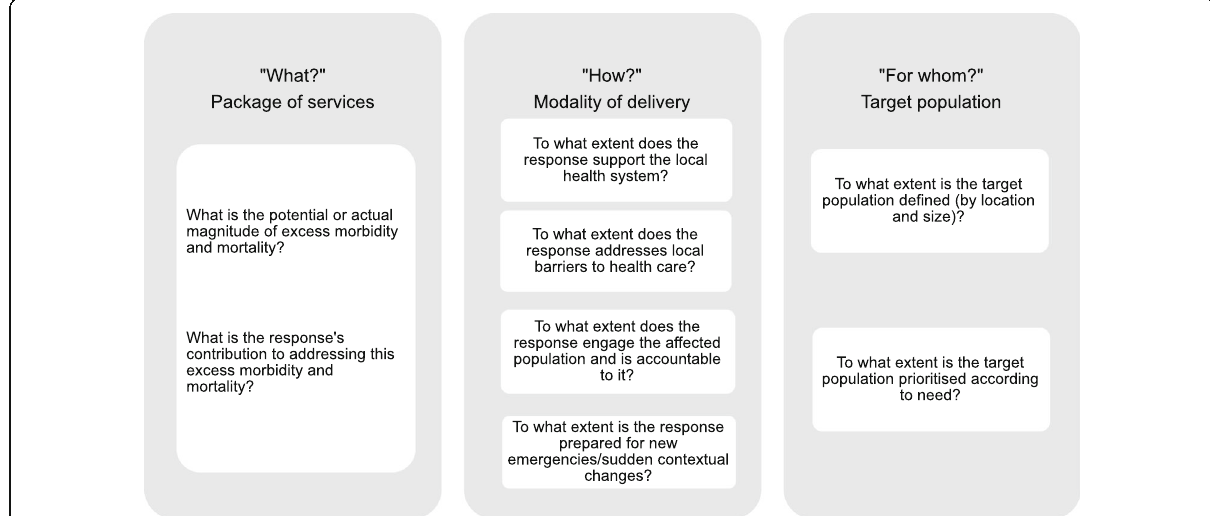
Fig. 2 The conceptual framework adapted for the health and nutrition